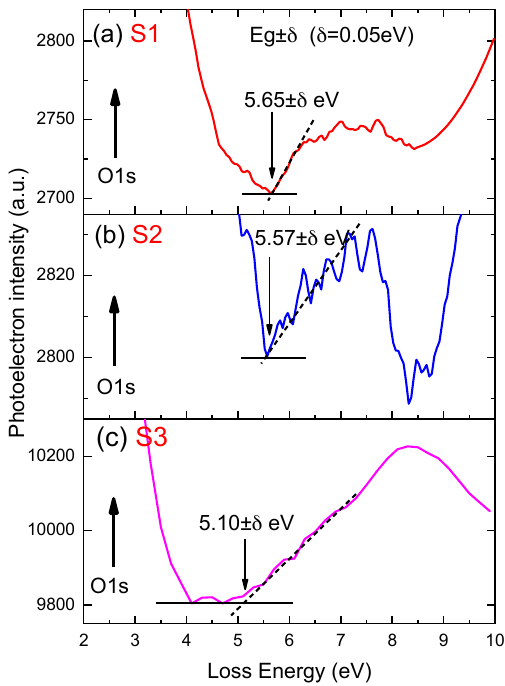
Figure 4. The photoelectron energy-loss spectra from the O 1s peaks of HfO 2 films for S1, S2 and S3 by XPS are shown in ( a – c ), respectively.